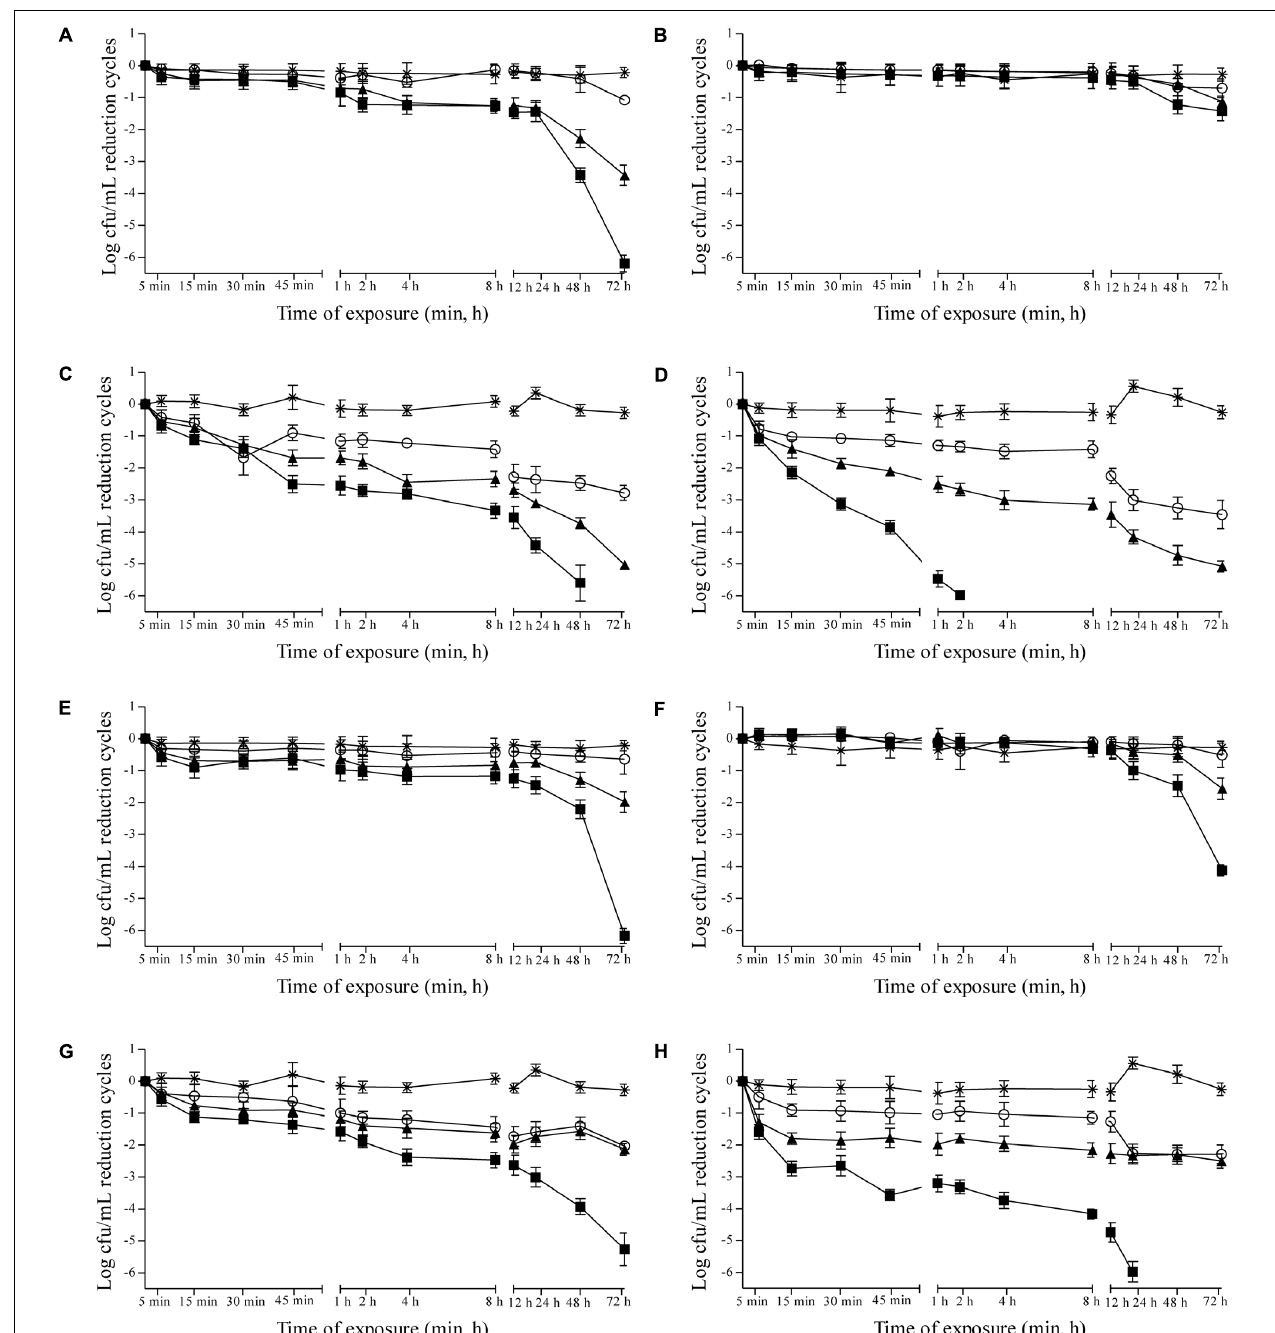
FIGURE 1 | Reduction cycles (log cfu/mL) of the counts of C. albicans ATCC 90028 (A,E) , C. tropicalis ATCC 28707 (B,F) , P. anomala ATCC 40101 (C,G) and S. cerevisiae ATCC 2601 (D,H) in cashew juice at 4 ± 0.5 ◦ C as a function of the concentration of M. spicata L. essential oil (A–D) at ( (cid:4) ): 3.75 µ L/mL, ( (cid:78) ): 1.875 µ L/mL, ( ◦ ): 0.9375 µ L/mL or M. villosa Huds. essential oil (E–H) . ( (cid:4) ): 15.0 µ L/mL, ( (cid:78) ): 7.5 µ L/mL, ( ◦ ): 3.75 µ L/mL, ( ∗ ) control: 0 µ L/mL. Detection limit of the test: 1 log